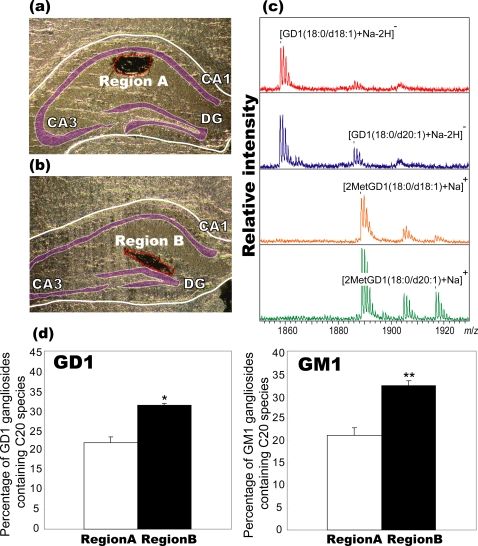
Localization of C20-sphingosine-containing gangliosides was confirmed by MS of extracted and methyl-esterified gangliosides.To determine the percentage of GM1/GD1 gangliosides containing the C20-species in different regions without allowing sialic acid dissociation during MS measurement, we extracted gangliosides from the dendritic region of the SR (region A, (a)) and the ML/SLM (region B, (b)). They were derivatized to methyl-esterified gangliosides. From the result of MS of underivatized gangliosides and methyl-esterified gangliosides (c), the percentage of GM1/GD1 gangliosides containing the C20-species were calculated (d). Three different mouse brain sections were used, and the data were expressed as mean±S.D. * and ** indicate P<0.05 and P<0.005, respectively, Student's t-test.